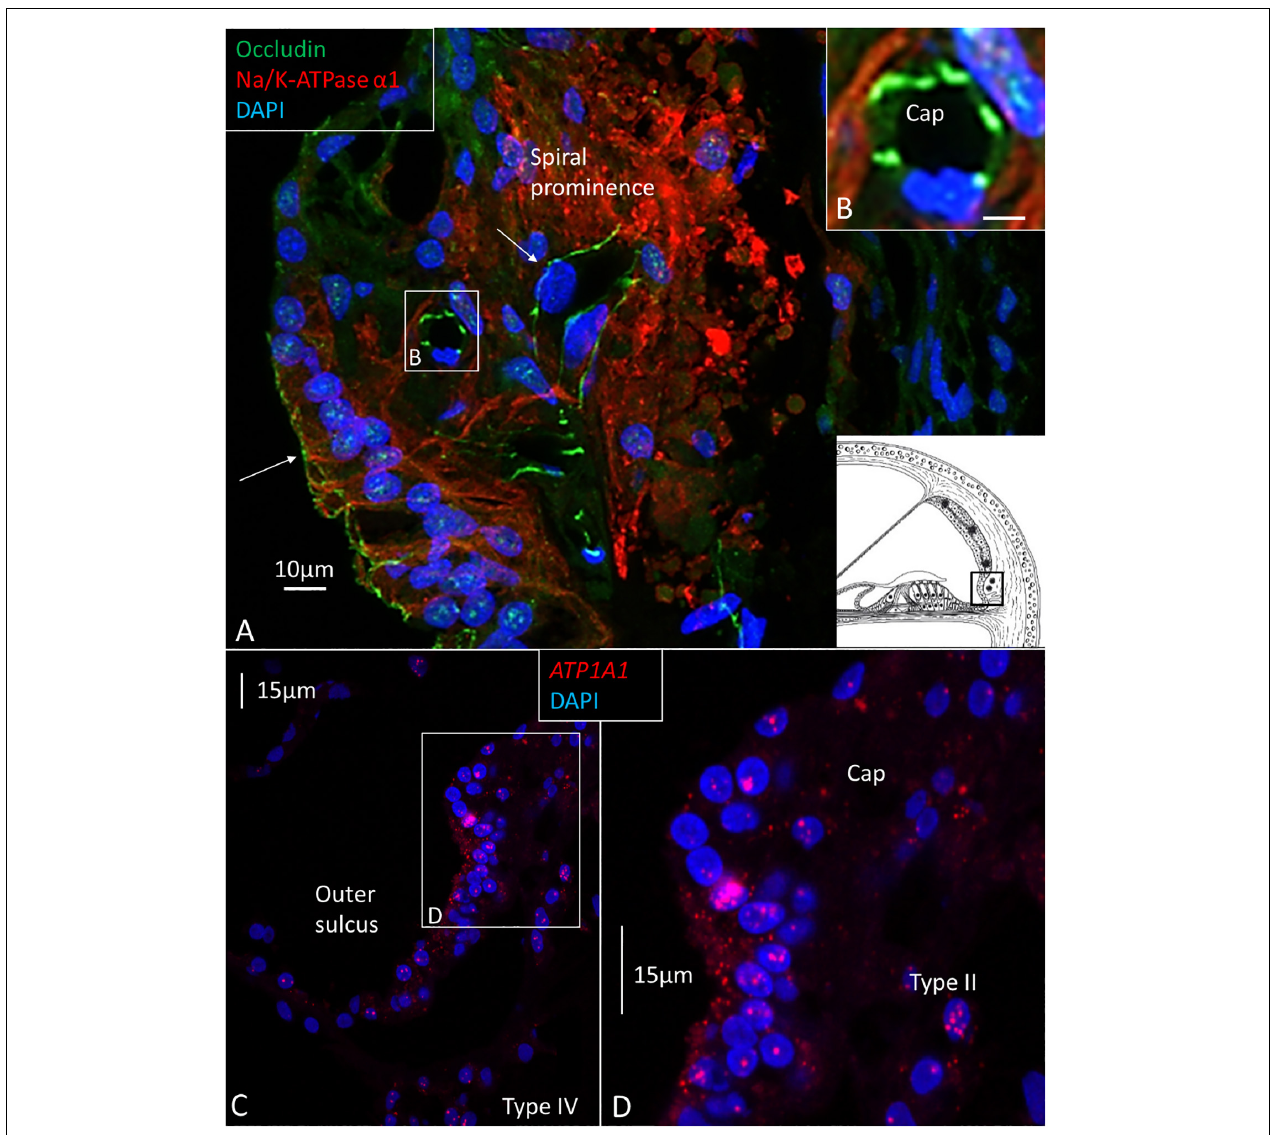
FIGURE 6 | (A) Confocal immunohistochemistry of human spiral prominence. The tight junction protein occludin is expressed in epithelial cells and capillary endothelium (Cap) (arrows). The basolateral cell membrane of the epithelial and type II cells express NKA α 1. Framed area is magnified in inset (B) and shows expression of occludin. NKA α 1 and occludin are separately expressed. (C) RNAscope R (cid:13) and SR-SIM of outer sulcus and spiral prominence show expression of ATP1A1 in the epithelium and type II fibrocytes. A few gene puncta are also seen in the type IV fibrocytes. Framed area is magnified in (D) and shows ATP1A1 richly expressed in the outer sulcus epithelium, root cells, and type II fibrocytes. There are no ATP1A1 transcripts in the blood